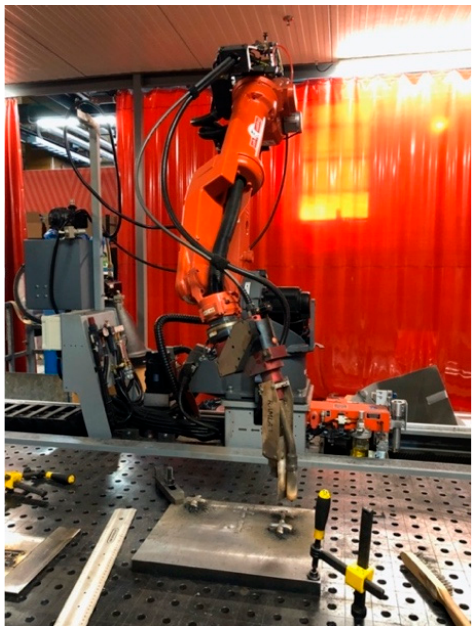
Figure 8. Welding robot as the main element of wire arc additive manufacturing (WAAM) printing.